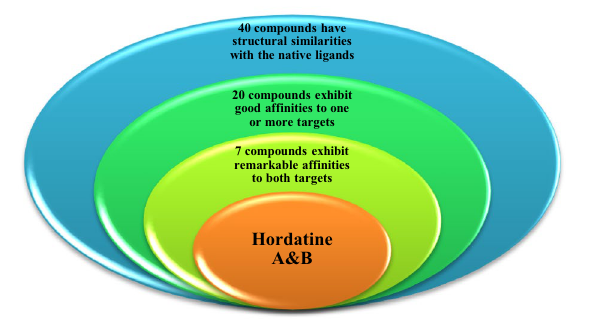
Fig. 6 An outline of the employed virtual screening